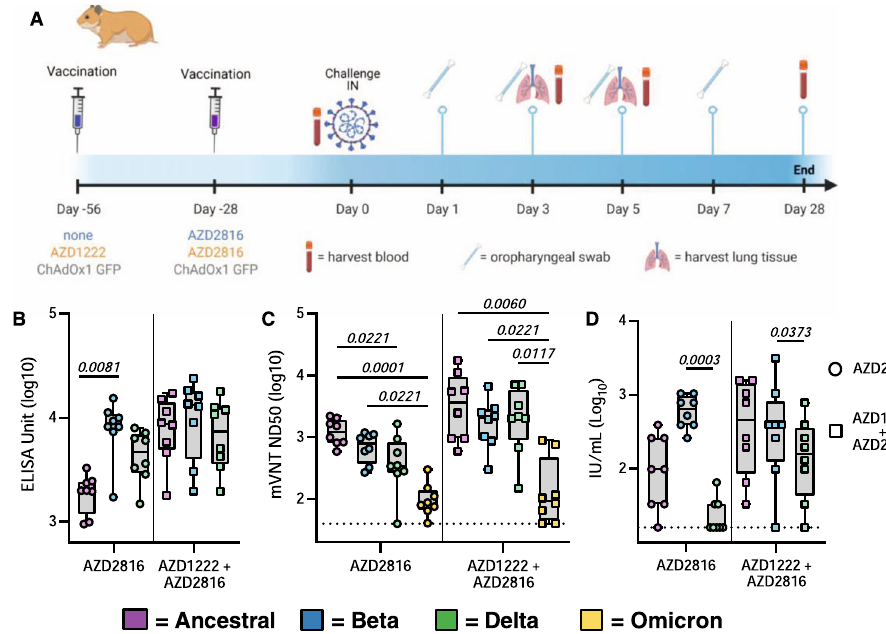
Fig. 1 | Humoral response of Syrian hamsters vaccinated with a single dose of AZD2816, a prime dose of AZD1222 and boost dose of AZD2816, or a prime- boost regimen of ChAdOx1 GFP. A Schematic overview of experiment. Hamsters were vaccinated with AZD2816 on day − 28, AZD1222 on day − 56 and AZD2816 on day − 28, or ChAdOx1 GFP at day − 56 and − 28. Created with BioRender.com. B BoxplotofbindingantibodiesagainstSproteinofSARS-CoV-2(ancestral,Beta,or Delta) in serum obtained on day 0. C Boxplot (minimum to maximum) of